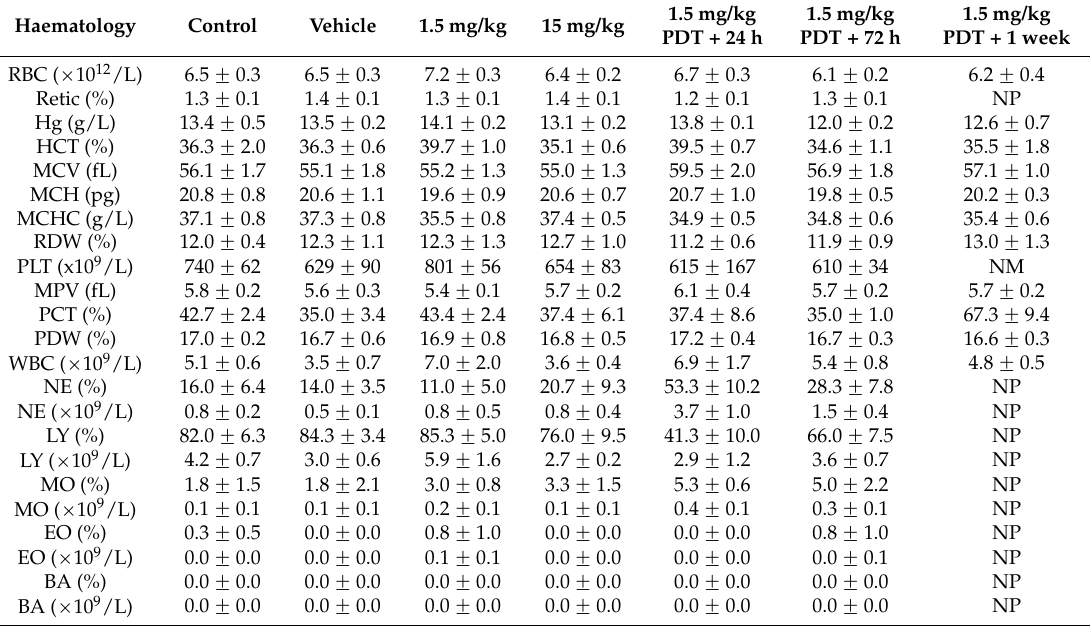
Table A1. Results of the haematology tests from all study groups, presented as average ˘ SD. Haematology